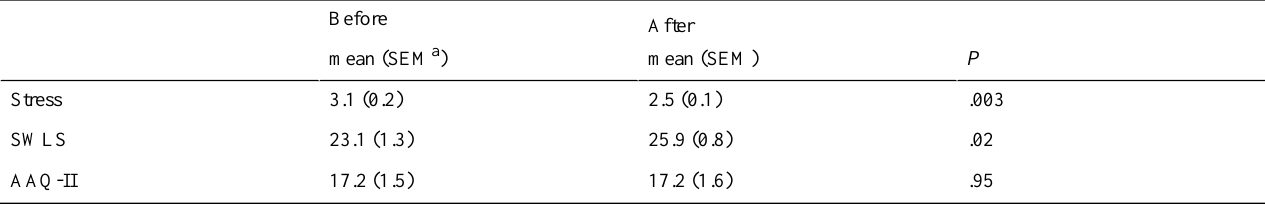
Table 1. Ratings of stress and scores in SWLS and AAQ-II questionnaires before and after using Oiva.